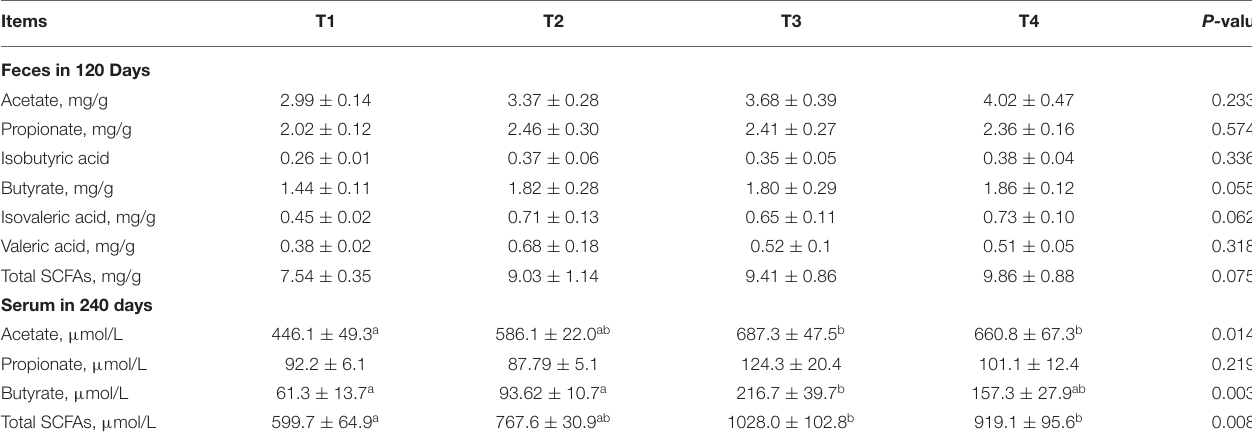
TABLE 7 | Effect of dietary fiber and metabolites on short-chain fatty acids (SCFAs) concentrations of